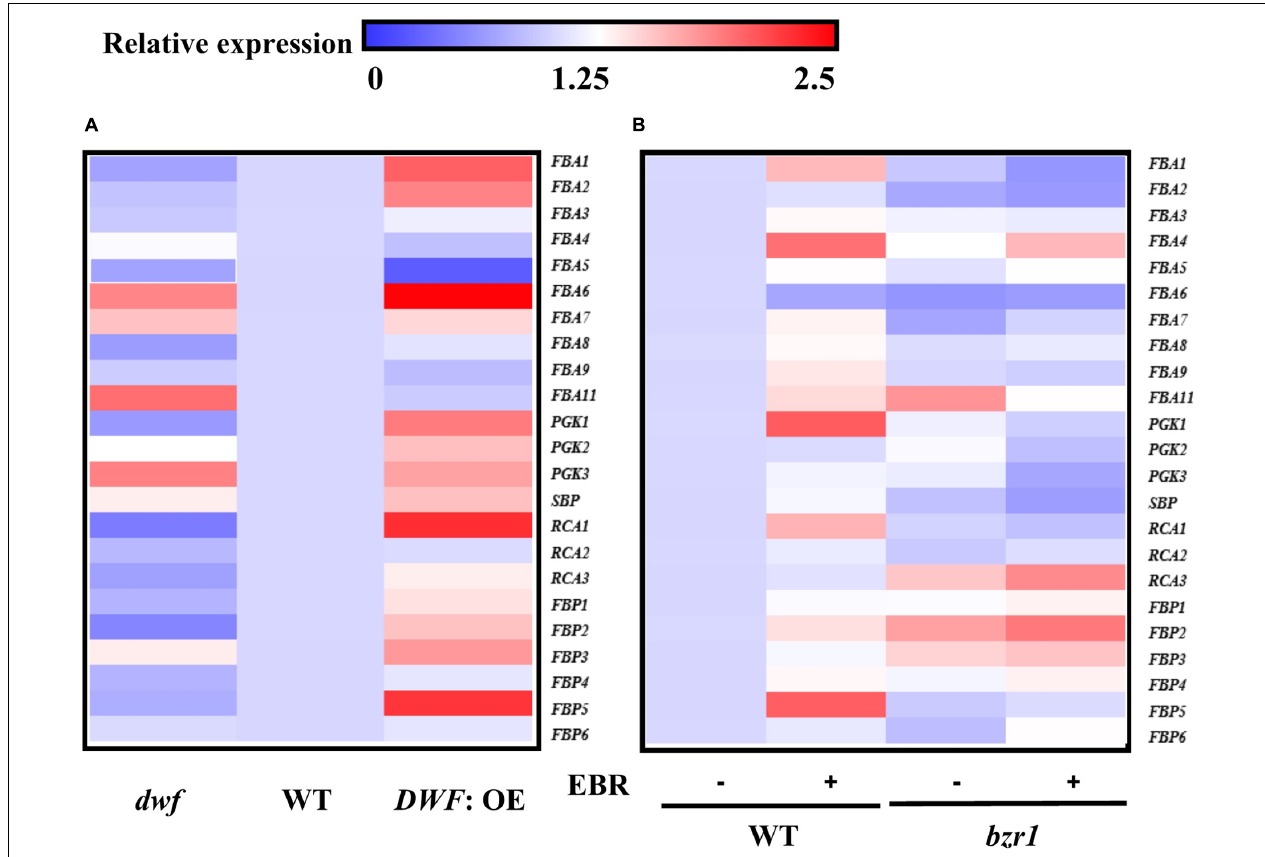
FIGURE 3 | Influence of brassinosteroids (BRs) and BZR1 levels on the transcription of Calvin cycle genes. (A) Transcription of Calvin cycle genes in different endogenous BR levels plants. (B) Transcription of Calvin cycle genes in different BZR1 levels plants. EBR (200 nM) was applied at 8:00 in the morning. Overall, 6 h after the application, leaf samples were collected for gene expression analysis. Actin and α -tubulin 3 were used as the reference genes here. The data of transcription of genes represent the means ± SD of three biological replicates. Three independent experiments were performed with similar